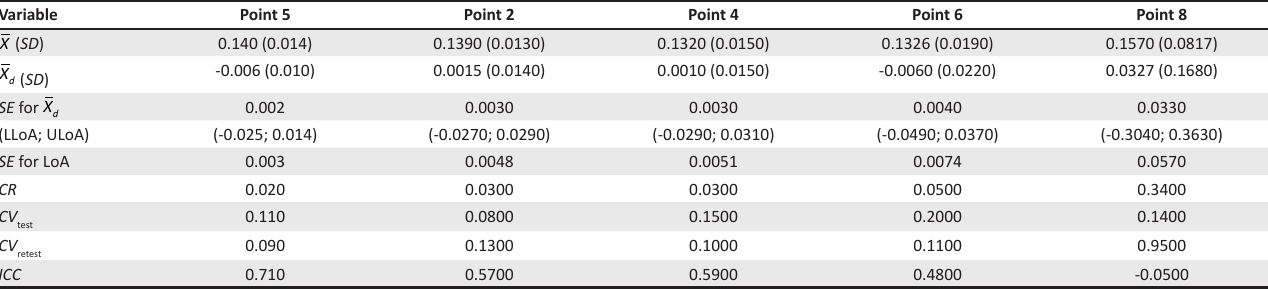
TABLE 4: Descriptive statistics for the Bland–Altman plots for oscillatory sensitivity of Points 2, 4, 5 (fovea), 6 and 8. Variable